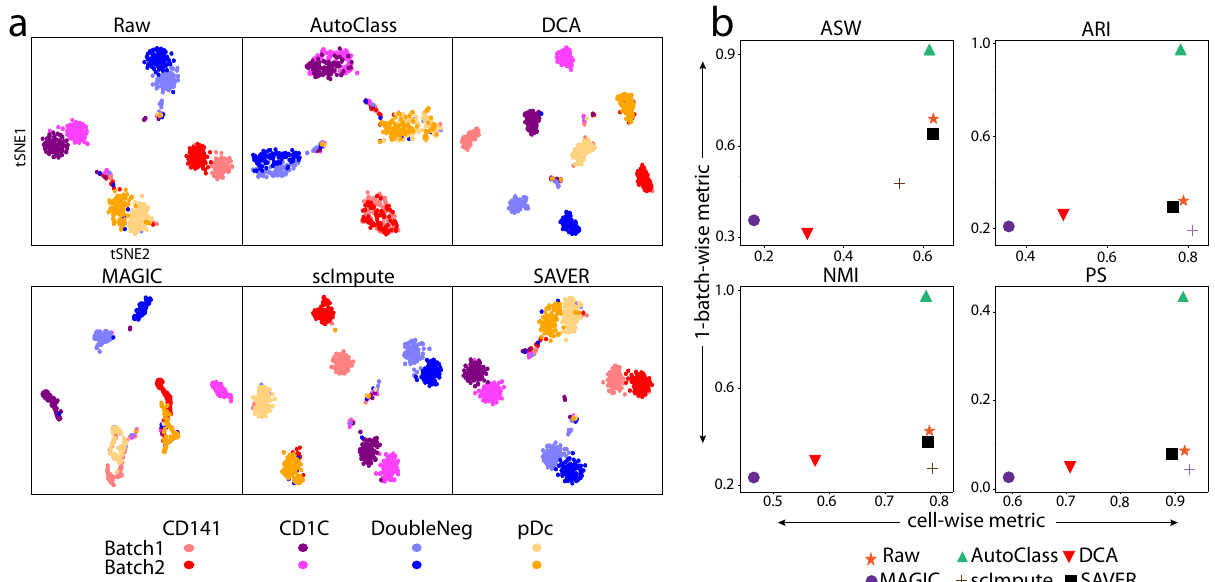
Fig. 5 Batch effect removal in the Villani dataset. a t-SNE plots for raw and imputed data. b Evaluation of batch and cell type separation in raw and imputed data by four different metrics: average Silhouette width, adjusted Rand index, normalized mutual information, and purity score. Good performance is shown as big values in both X-(cell type separation) and Y-(batch effect removal)